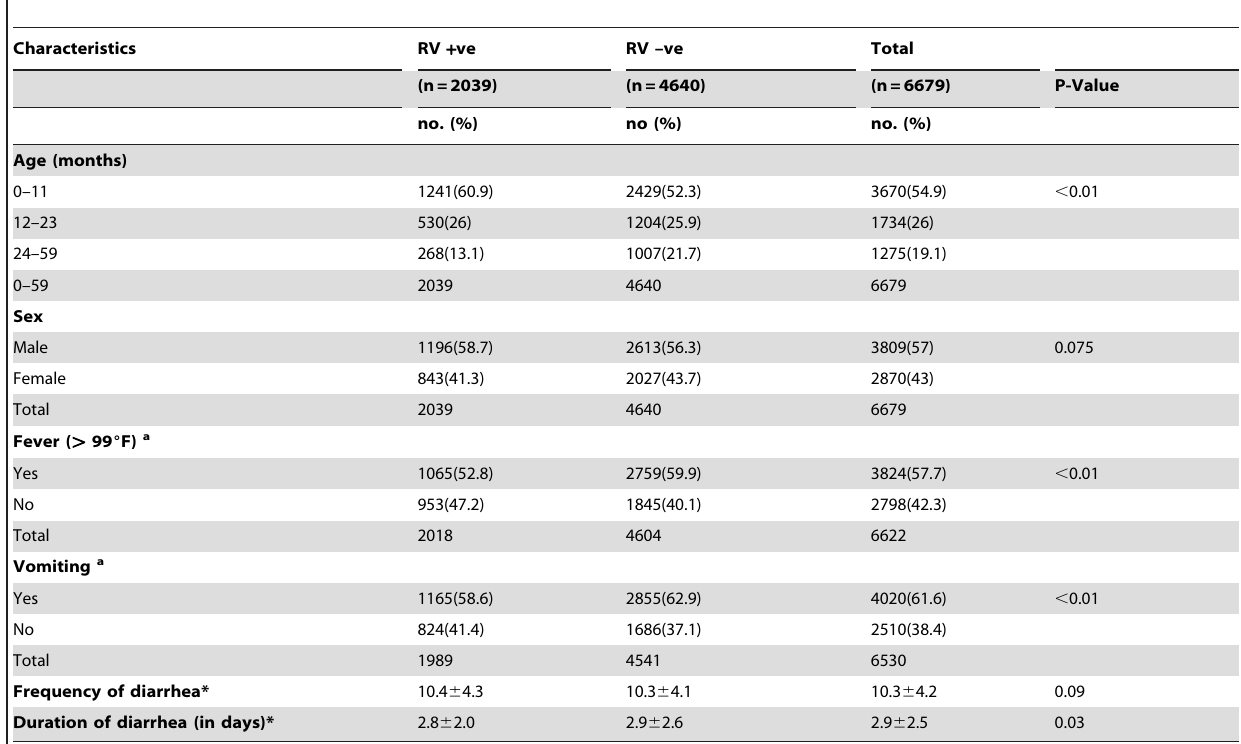
Table 1. Comparison of clinical features of children under 5 years of age with rotavirus positive gastroenteritis and rotavirus negative gastroenteritis admitted in five hospitals in Pakistan from 2006 – 2008.